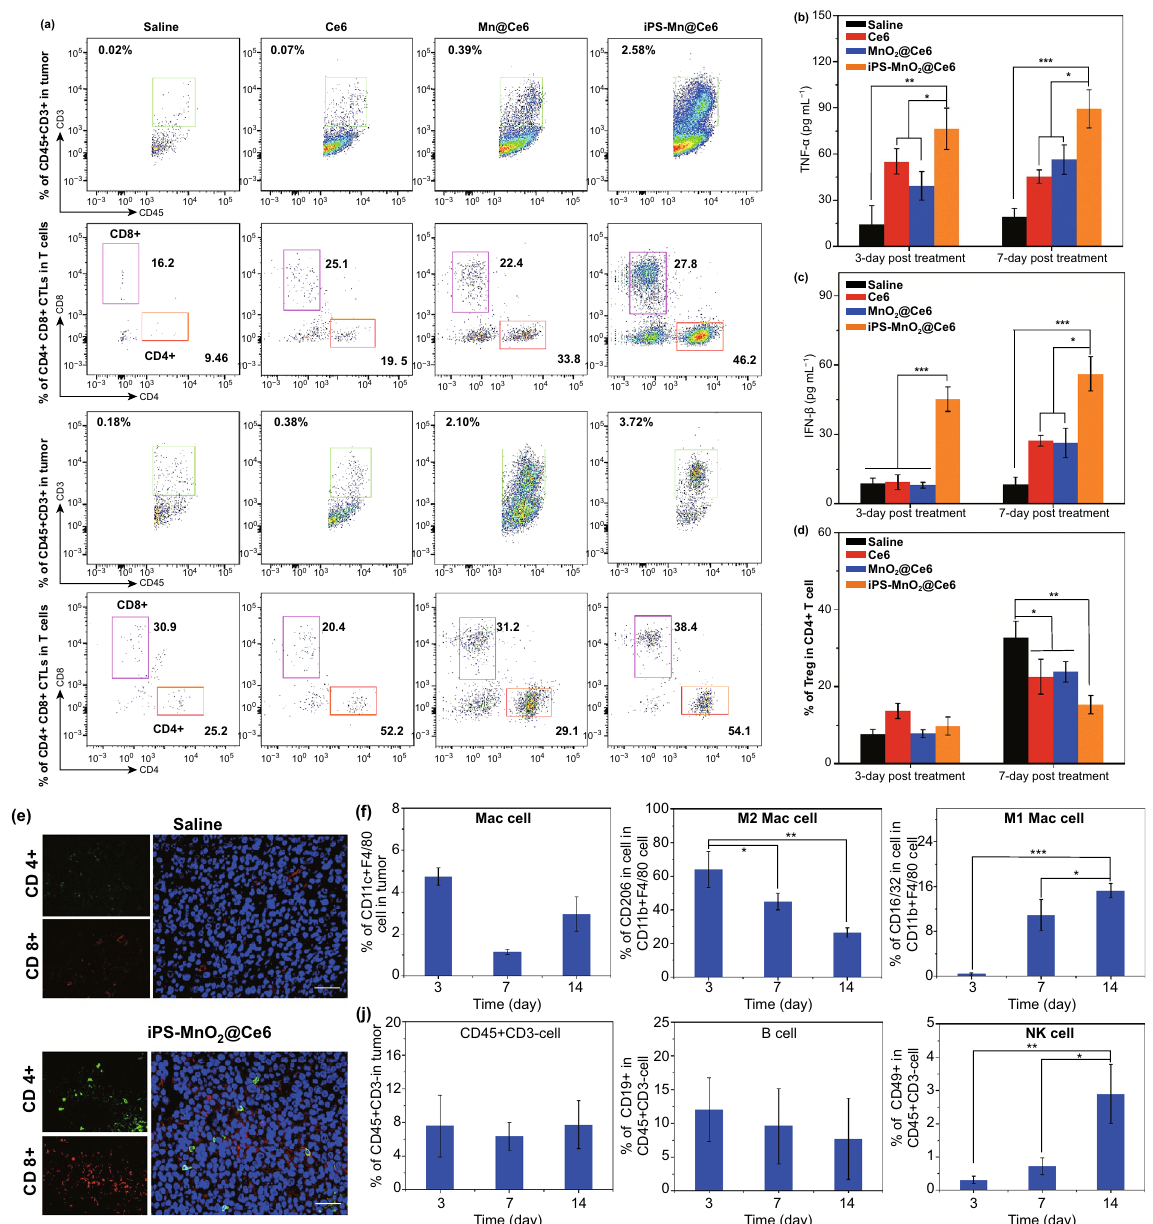
Fig. 6 T cell response-based immunotherapeutic effect of iPS-MnO 2 @Ce6 in tumors. a Representative flow cytometric plots of CD4+ and CD8+ CTL in CD45+ CD3+ T cells for tumors from various groups at different time points post-laser-mediated treatments. The contents of b TNF-α and c IFN-β in tumor tissues from each groups at different time points after treatments. d The proportions of CD4+ Foxp3+ regulatory T cell (Treg) in CD4+ T cells. e Representative immunofluorescence images of tumor slides showing CD4+ and CD8+ T cells infiltrating into the tumor tissues. Green from CD4 antibody, red from CD8 antibody, and blue from DAPI. Scale bars are 50 μm. f The infiltrations of CD11c+ F4/80 cells (Mac cells), M2 Mac cell, and M1 Mac cell in tumors, j B cells and NK cells in tumors at different time points post treatments of iPS-MnO 2 @Ce6. Data were expressed as mean ± SD, ( n = 5, * P < 0.05, ** P < 0.001, *** P <